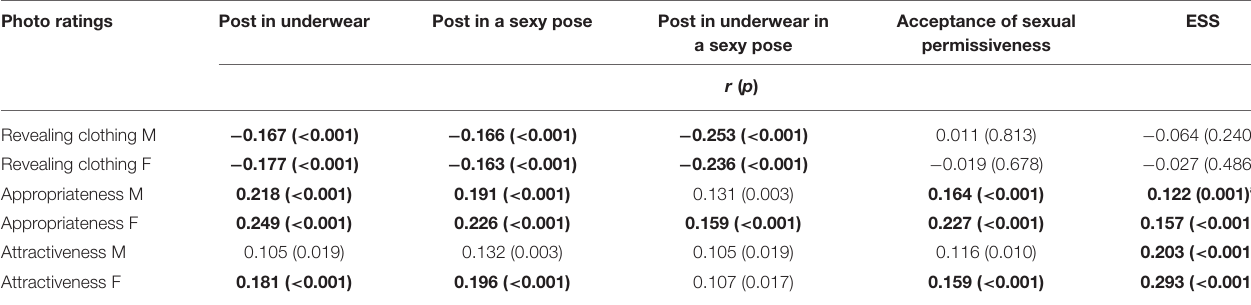
TABLE 3 | Partial correlations between Instagram photo ratings and the variables of self-sexualization in the female subsample. Photo